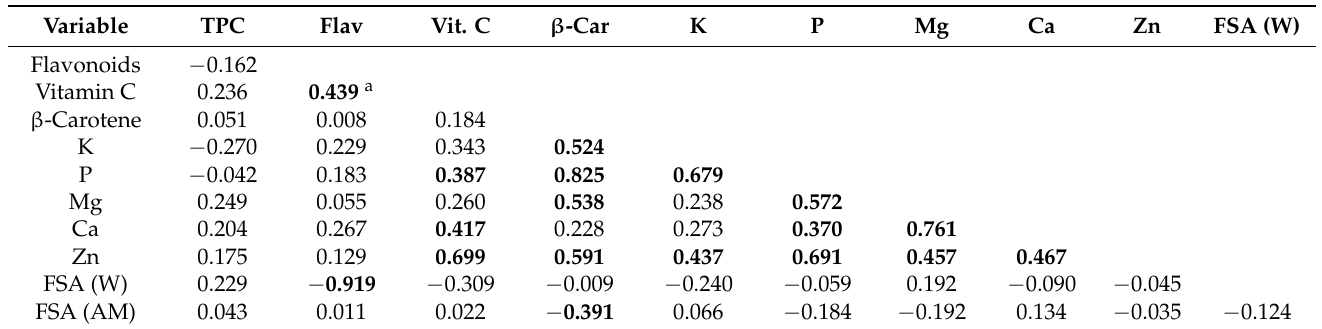
Table 2. Pearson correlation of nutritional and phytochemical traits of cantaloupe and honeydew melon cultivars at harvest.